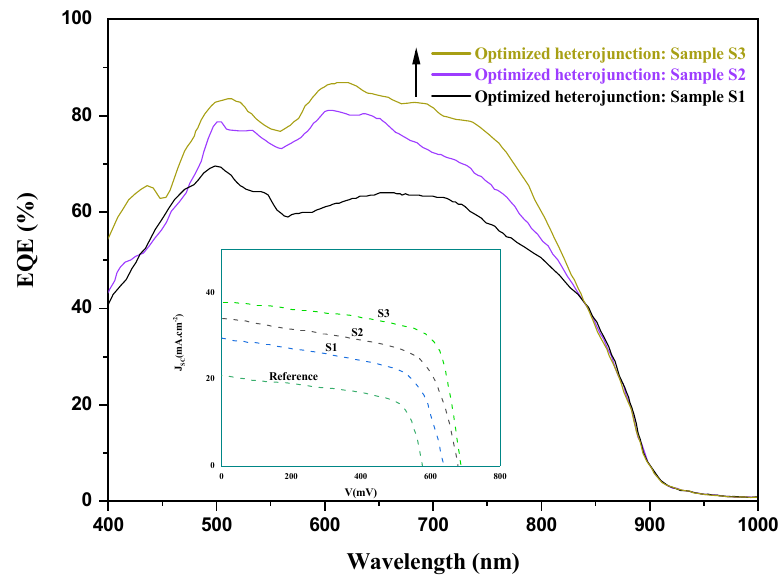
Figure 12. The external quantum efficiency (EQE) spectra of n-ZnO/p-GaAs heterojunction solar cells: (S1) heterojunction with a gettered GaAs substrate via the VTP2 process and an optimized emitter thickness of 391 nm, (S2) same as S1 with the incorporation of microgrooves at the heterojunction interface, (S3) same as S2 with the introduction of ZnO nanorods at the front surface of the emitter to boost the absorption at the front side of the device. The illuminated J-V characteristics are shown in the inset.